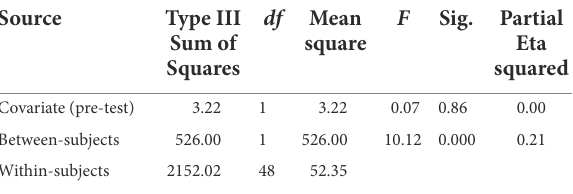
TABLE 3 ANCOVA results, investigating the effect of flipped classroom on the EFL students’ writing performance after controlling for the